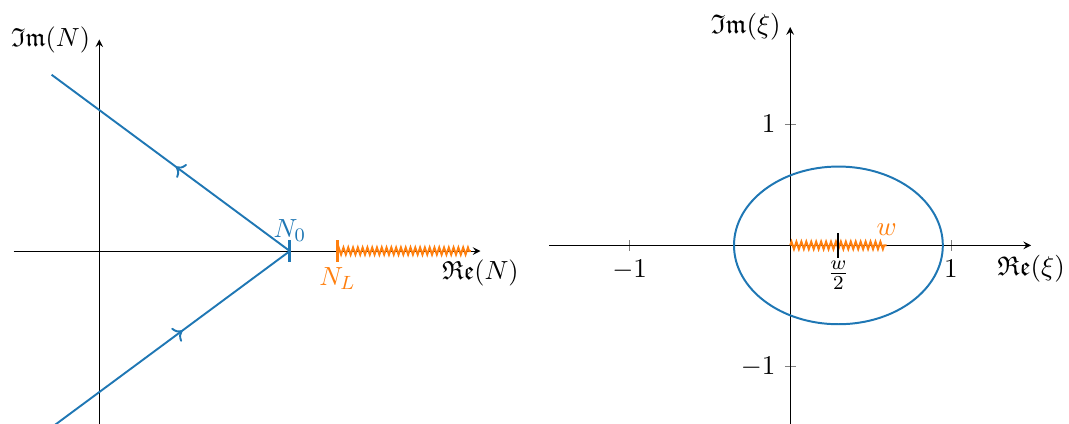
Figure 3. Branch cut of the integrand term M ( N, ξ p , ξ )Σ( N, w/ξ, α s ) in the w -integral given in eq. (2.20); H is given by the blue